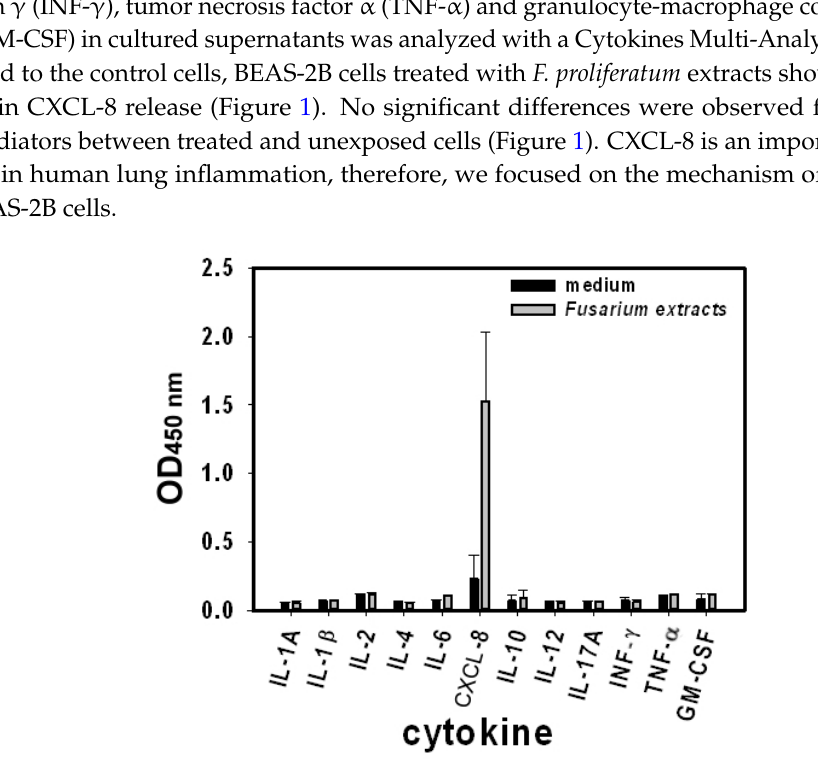
Figure 1. Fusarium proliferatum- induced cytokines released from human lung epithelial BEAS-2B cells. BEAS-2B cells were stimulated with F. proliferatum extracts (100 µ g/mL) and were incubated for 24